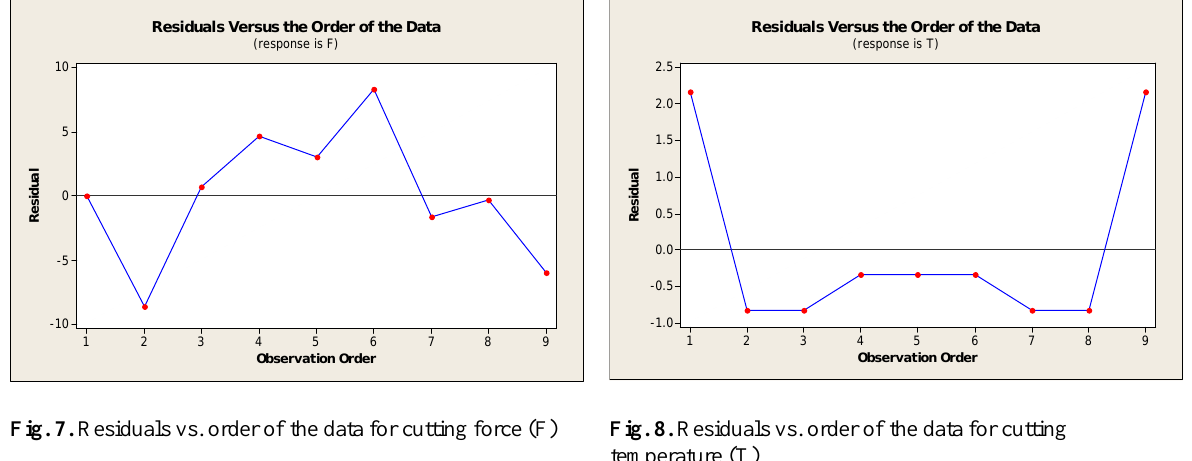
Fig. 7. Residuals vs. order of the data for cutting force (F) Fig. 8. Residuals vs. order of the data for cutting temperature (T)